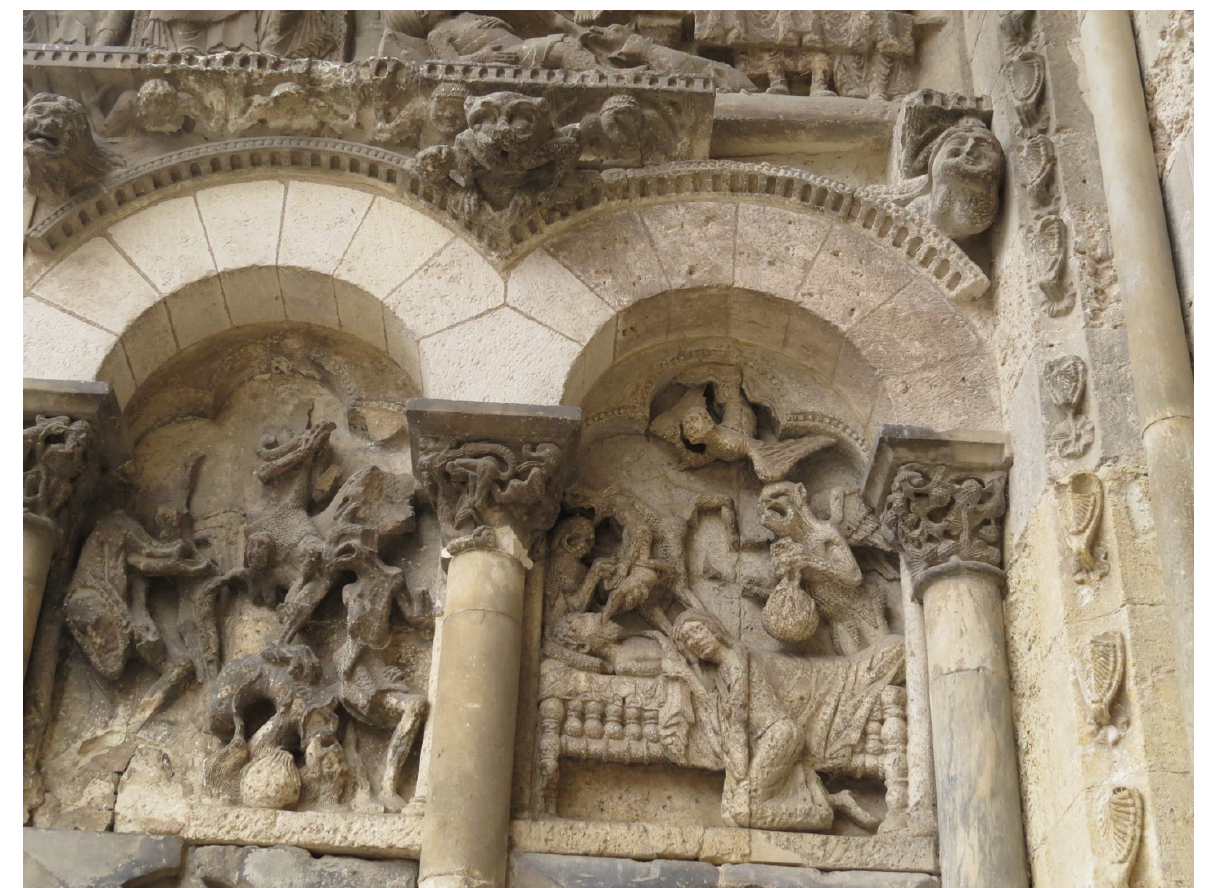
Figure 31. Dives, detail of west wall, south portal, Saint-Pierre-de-Moissac Abbey, 1115–1130, Moissac, Tarn-et-Garonne, Occitanie, France. ©Author.